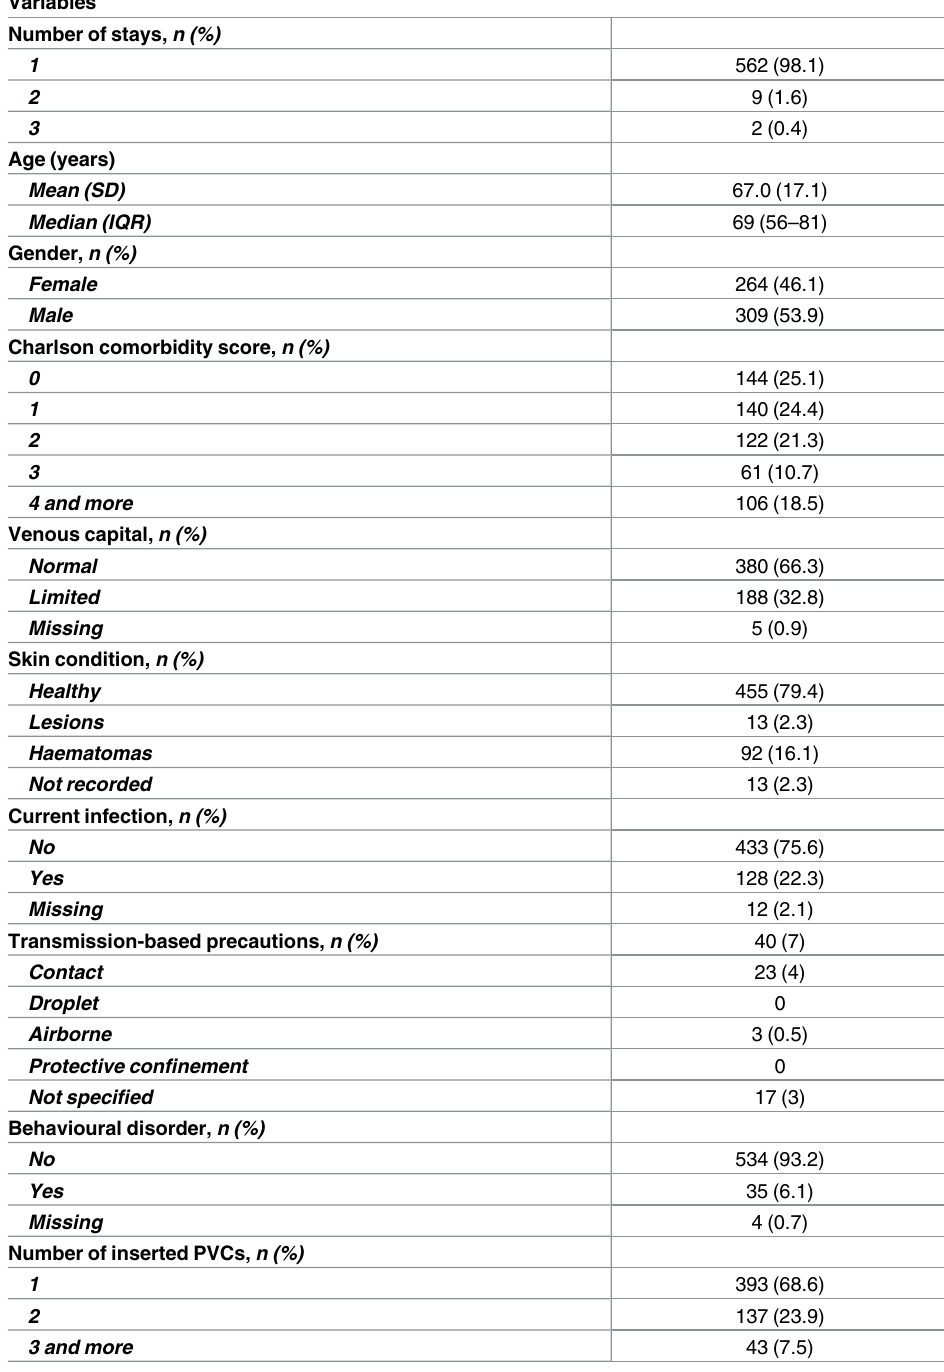
Table 2. Demographics and clinical characteristics of patients, N = 573